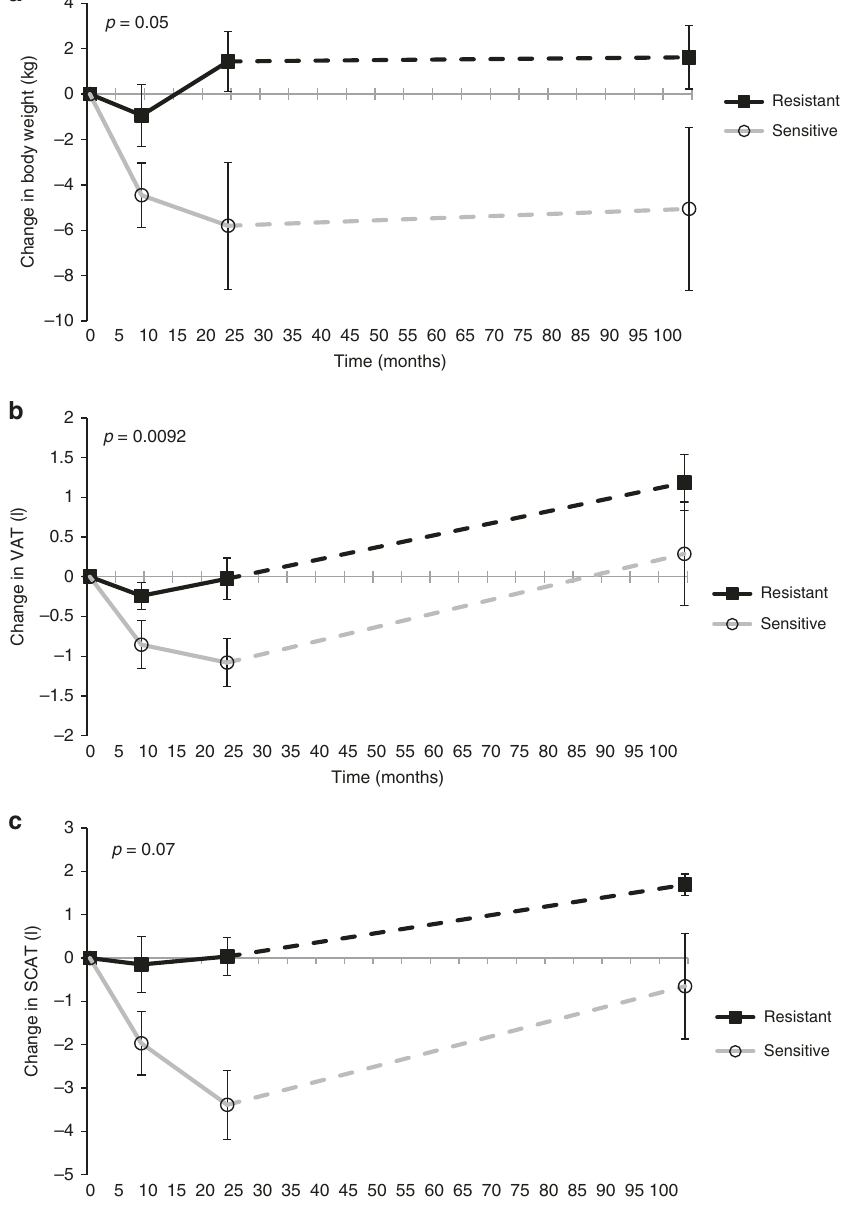
Fig. 1 Body composition during/after 9 years of lifestyle intervention depending on brain insulin sensitivity. ( a ) Changes in body weight; ( b ) changes in visceral adipose tissue (VAT); ( c ) changes in subcutaneous adipose tissue (SCAT). Brain insulin sensitivity was assessed as change in the theta frequency band in response to insulin infusion, corrected for saline infusion by magnetoencephalography. p values are from MANOVAs with brain insulin responsiveness as a continuous variable (brain insulin sensitivity × time). N = 15 ( a ), N = 12 ( b , c ); presented are means, error bars represent SEM. Filled boxes represent participants with brain insulin responsiveness below the median, open circles represent participants with brain responsiveness above the median. Continuous variables were used for statistical analyses and strati fi ed variables were used solely for better illustration of the results. Source data are provided as a Source Data fi